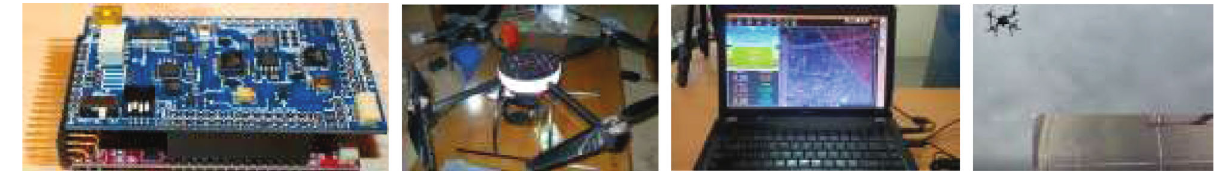
Figure 11: Installation and trial fl ights for the Q-UAV controller.